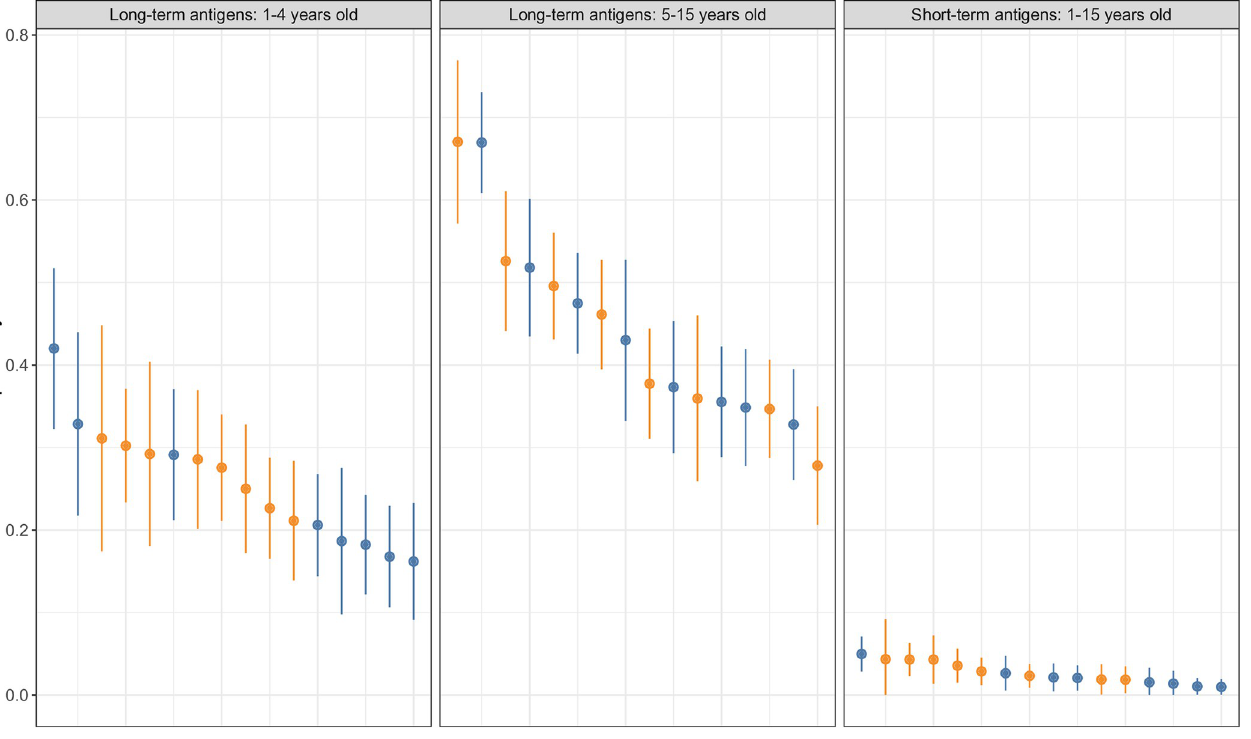
Fig 4. Seropositivity for each of the health facility catchment populations to long-term antigens, stratified by age (left and middle), and short-term antigens (right). Health facilities are ordered in each panel according to maximum seropositivity observed. RFTAT control (orange) and RFDA intervention (blue) arms are shown accordingly. Bars show 95% confidence